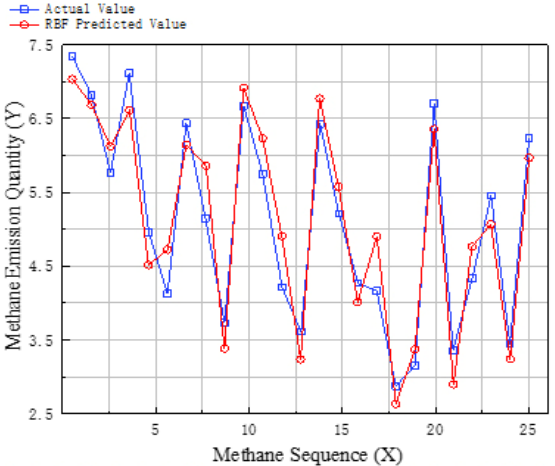
Figure 7. Comparison between grey RBF neural network model predicted value and actual value.